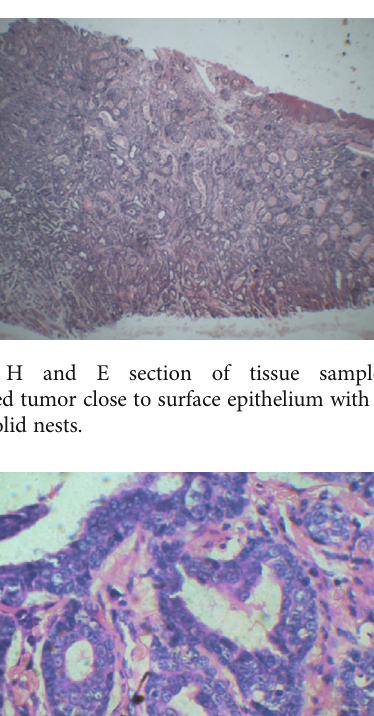
Figure 11: (a, b) Postsurgical maxillectomy specimen.